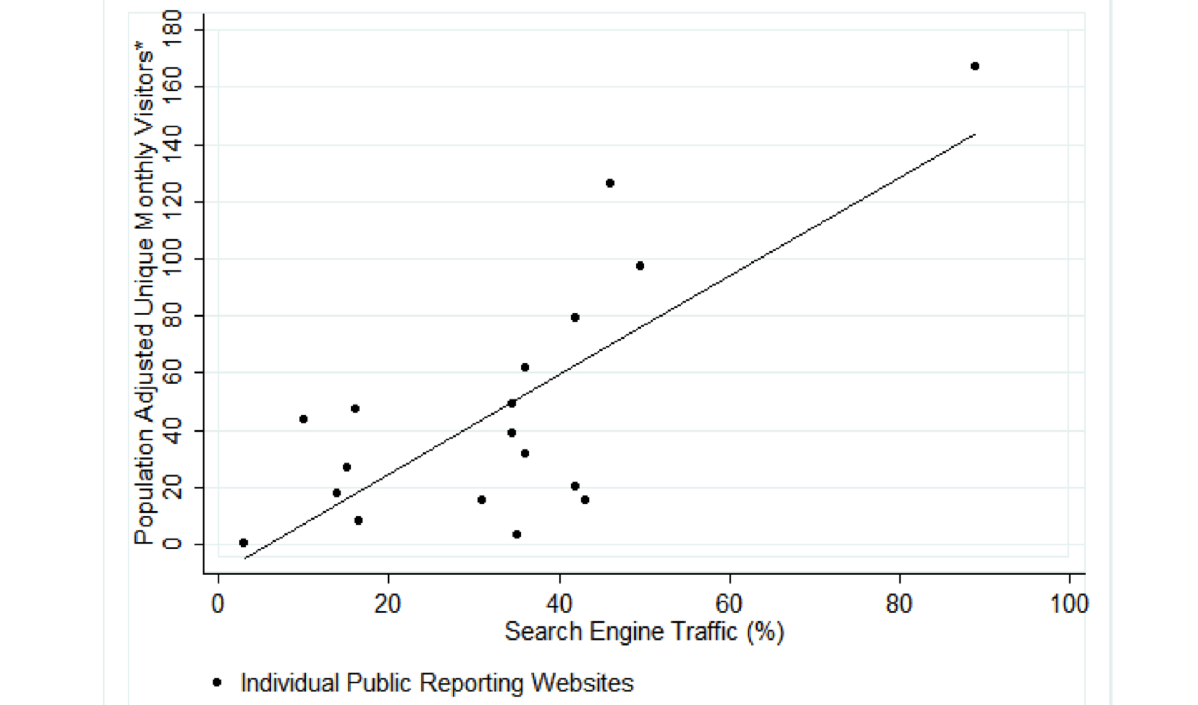
Route of arrival (N=116,657)